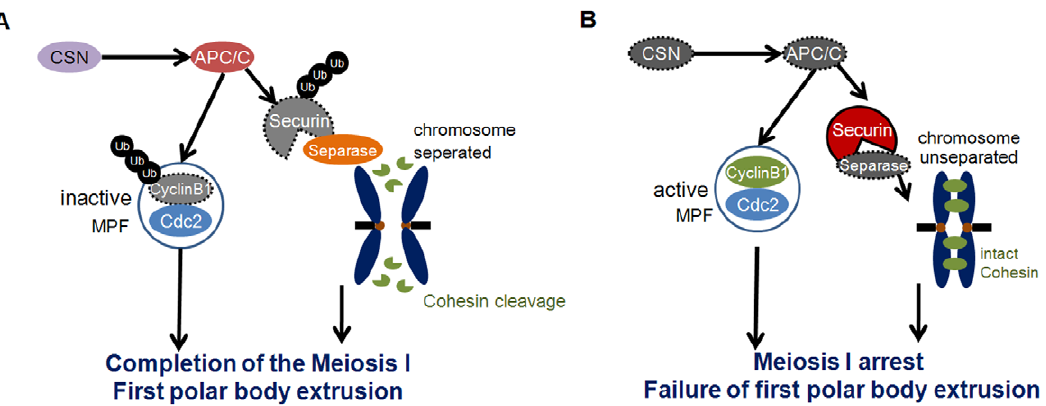
Figure 9. A schematic diagram depicting the proposed role of CSN in the control of meiotic chromosome segregation in oocytes based on loss-of-function of CSN3 or CSN5 . (A) CSN regulates APC/C activation, followed by degradation of Cyclin B1 and Securin. Degradation of Cyclin B1 induces MPF inactivation, while degradation of Securin induces activation of Separase that brings Cohesin cleavage and chromosome separation. Following these sequences, meiosis I is completed and first polar body is extruded. (B) When normal CSN is absent, APC/C is not activated, and degradation of Cyclin B1 and Securin are also failed. Maintained MPF activity and intact Securin resulted is maintained high, cohesions are intact, so chromosomes cannot be separated. And then meiosis I is failed; the oocytes are arrested at MI